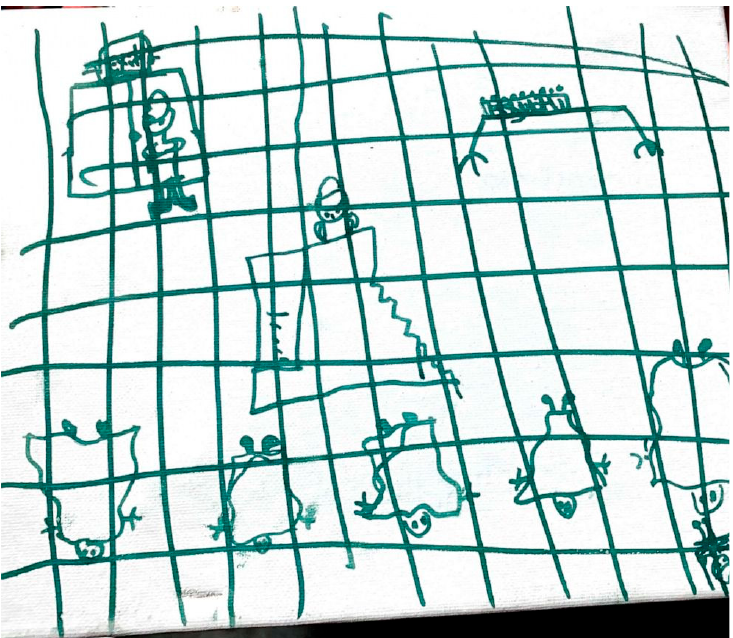
Figure 6. Drawing by primary school age child, gender redacted, held in an unspecified US detention Center, 2019. Courtesy of American Academy of Pediatrics.